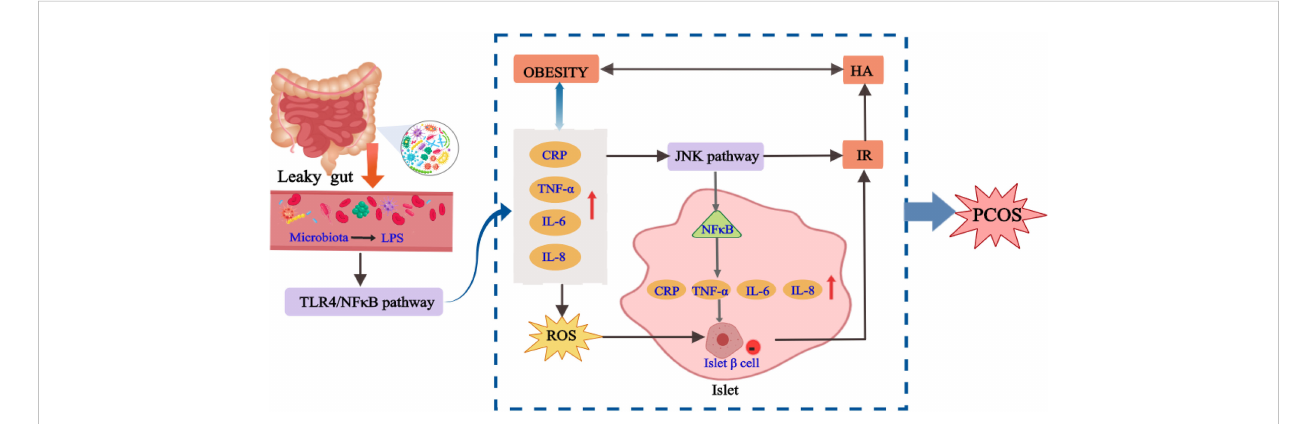
FIGURE 3 The internal relationship between chronic in fl ammation, intestinal fl ora and